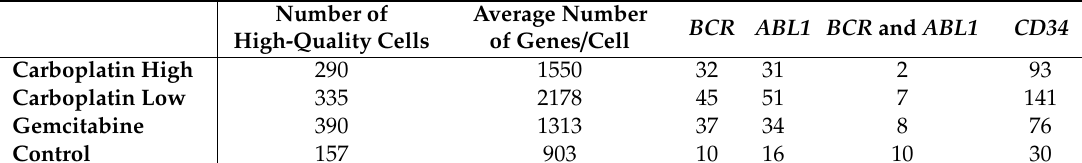
Table 2. High-quality cells and their gene expression.